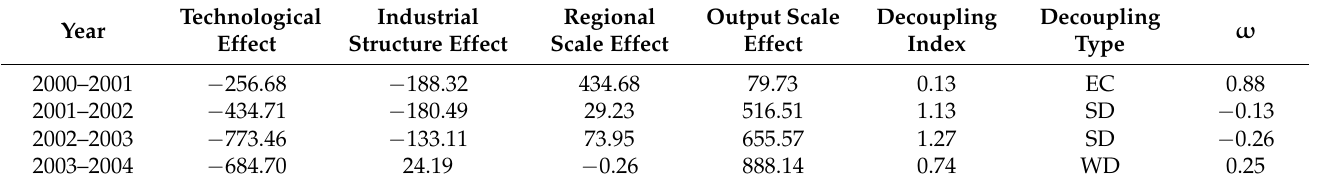
Table 5. Decoupling effort index of China’s water usage from 2000 to